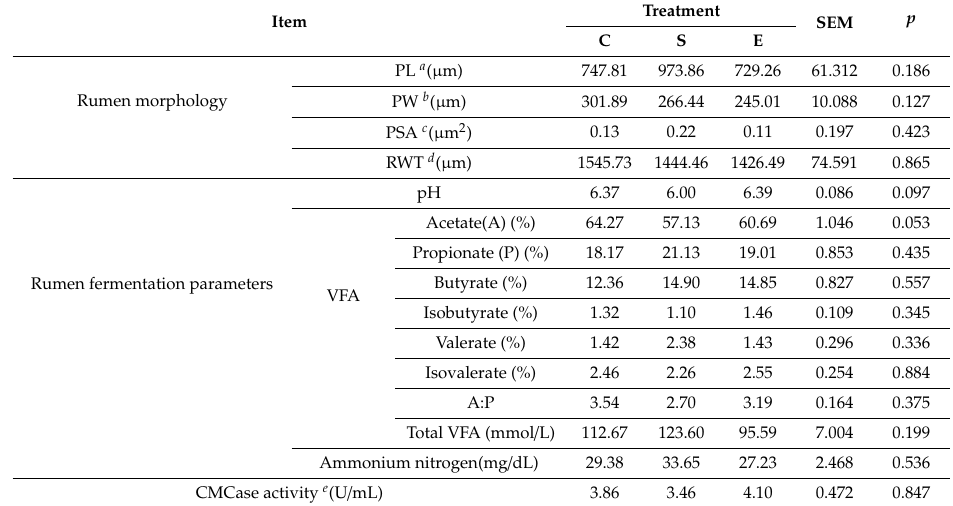
Table 3. E ff ect of mulberry leaf feed types on rumen morphology, fermentation and CMCase activity.